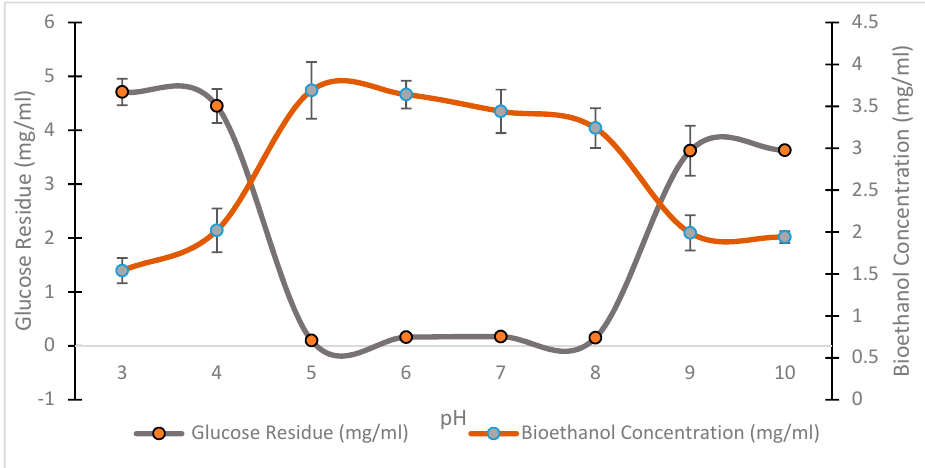
Figure 10. Effect of different pH values on the production of bioethanol using G4 yeast isolate and the residual glucose concentrations.